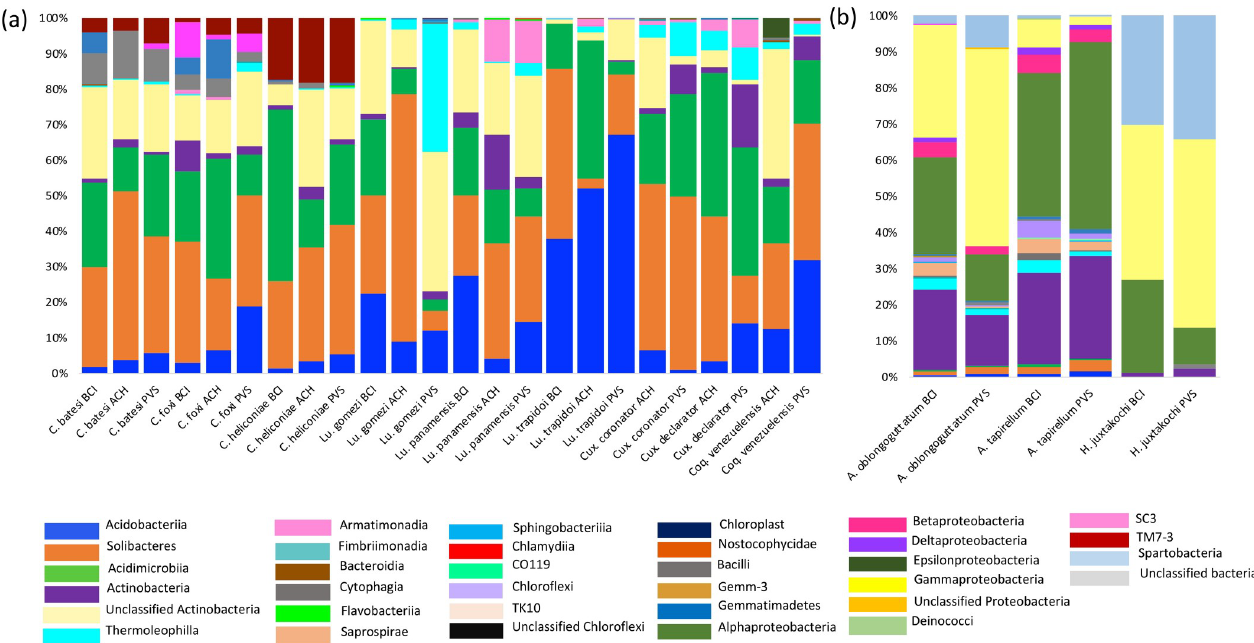
Fig 4. Relative abundances of bacterial classes summarized for (A) dipteran species and (B) hard ticks gathered from BCI (i.e., Pristine), ACH (i.e., intermediately disturbed) and PVAS (i.e., highly disturbed).